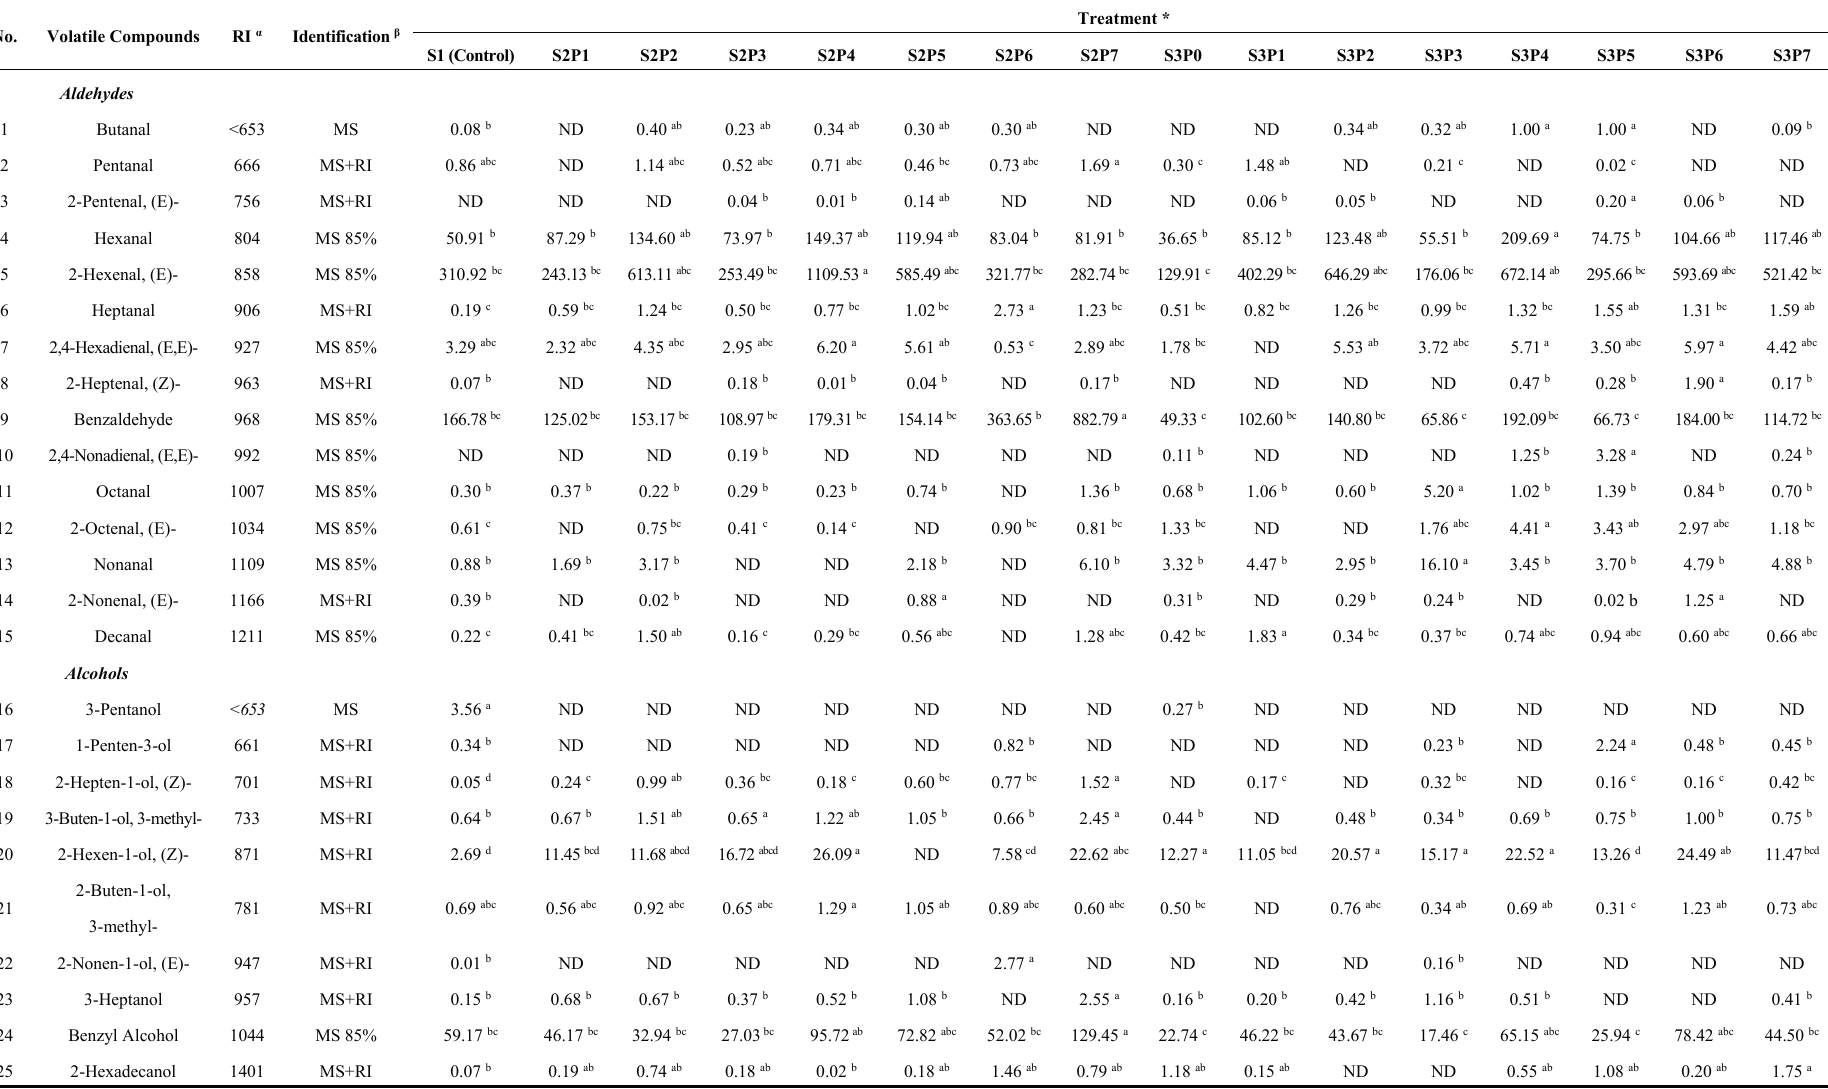
Table 1. Volatile compounds in control and PEF-treated cherries (immediately after PEF and 24 h after